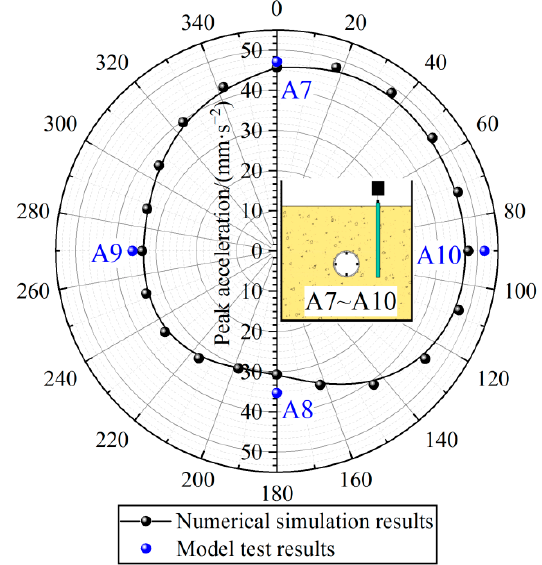
Figure 7. Peak acceleration at different locations of the tunnel lining (A7~A10).